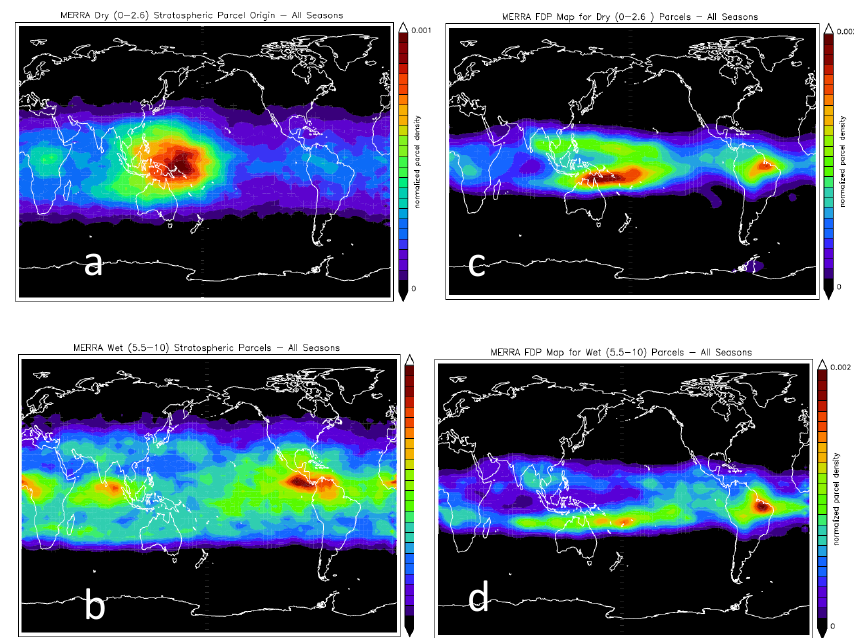
Fig. 9. 360K parcel density maps of dry (a) and wet (b) parcels in the stratosphere and FDP density maps of the driest (c) and wettest (d) air. Wettest parcels (5.5–10ppmv) are about 10% of the total number of parcels; driest (0–2.6ppmv) are about